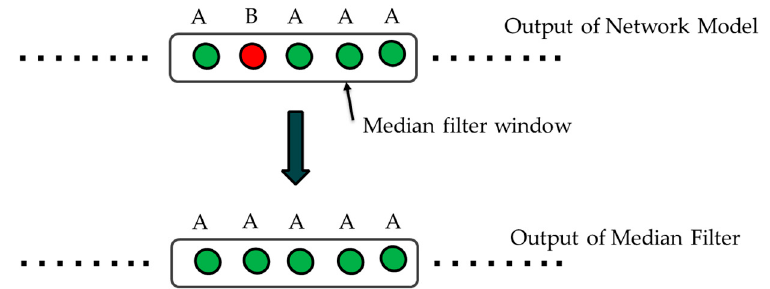
Figure 4. Filtering on Output.